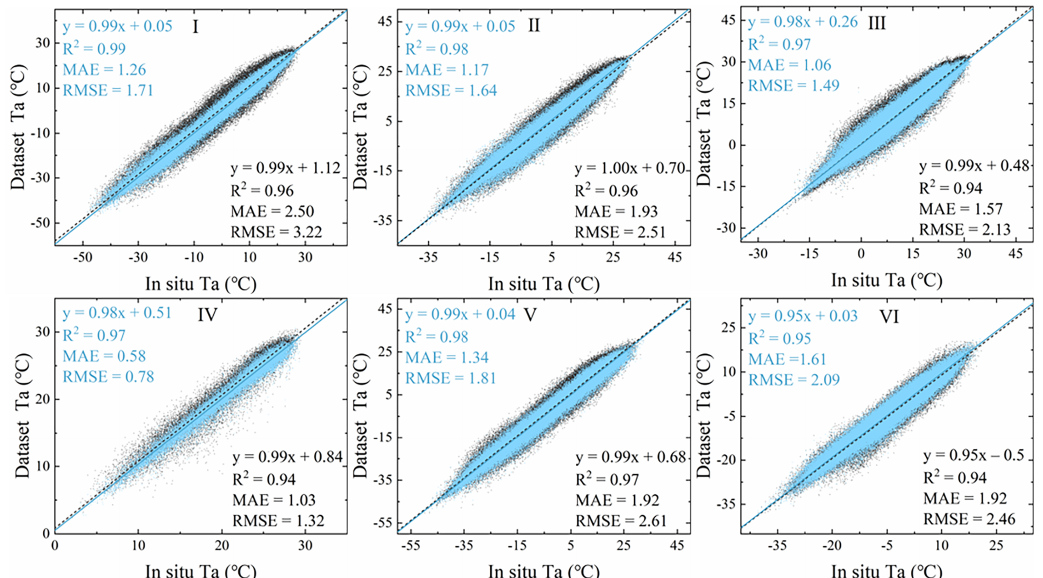
Figure 10. Scatter diagrams of the original T min and reconstructed results versus their corresponding ground station data in six natural subregions (I, II, III, IV, V, and VI). Gray points indicate low-quality pixel values in the original T min data, blue points represent the values in the after-calibration T min dataset; the statistical accuracy measures ( R 2 , MAE, and RMSE) are also indicated.